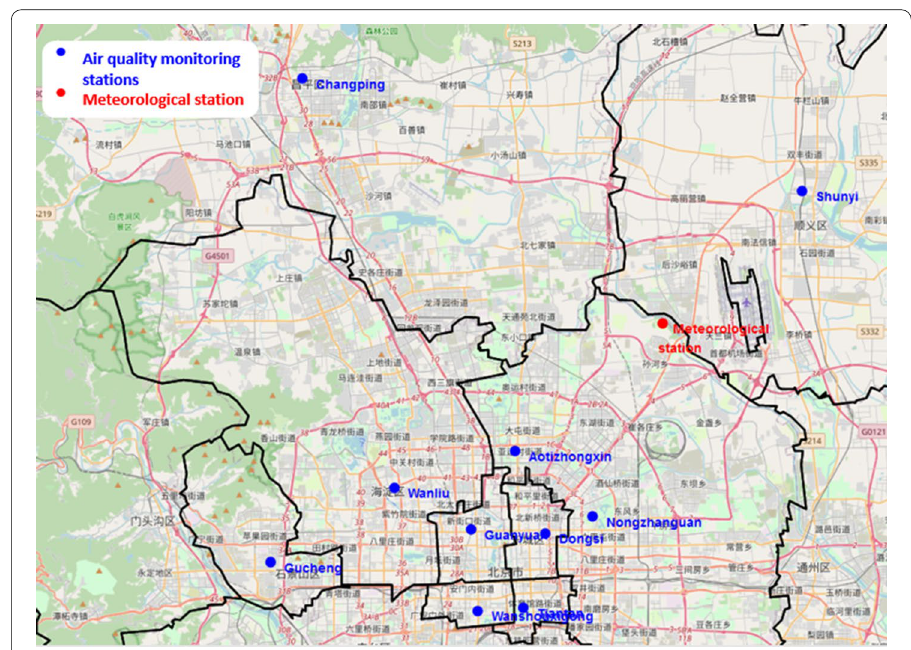
Fig. 6 The distribution of monitoring stations in